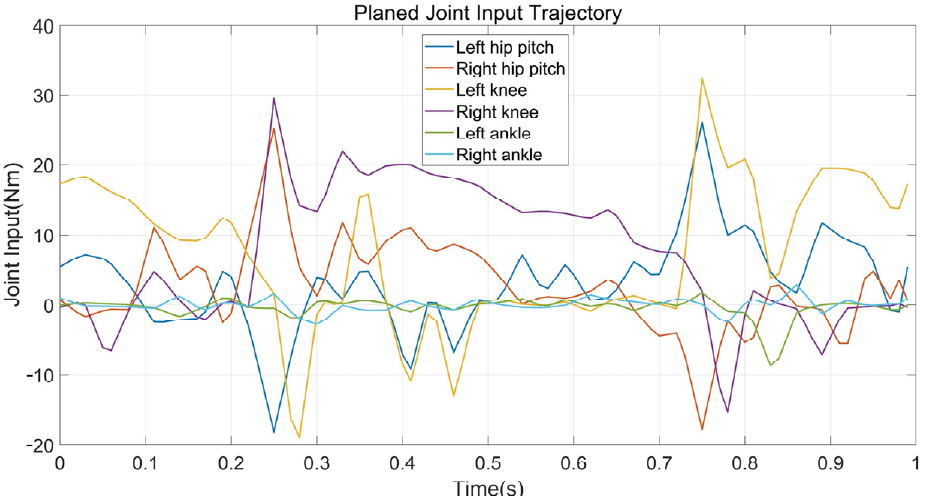
Figure 8. The planned input trajectories of planar walking on stairs.